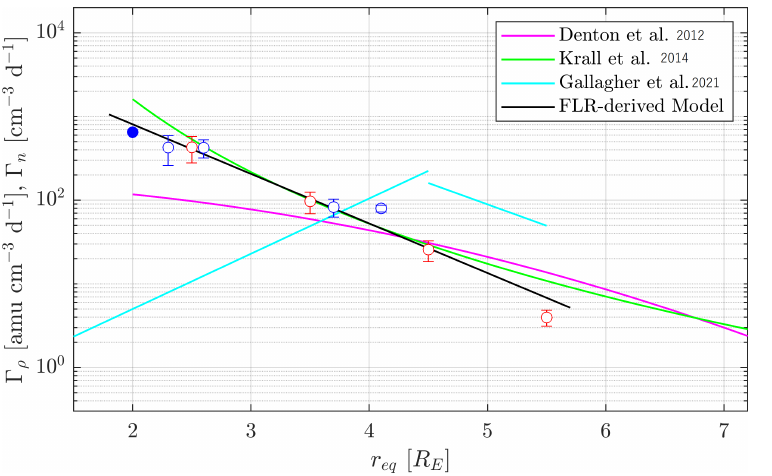
Figure 9. Geocentric distance dependence of the the day-to-day refilling rate estimated from FLRs observations in this (red circles) and in past works (blue circles) for the noon sector. The value indicated by the blue filled circle refers to 15:00 MLT. See Table 2 and text for details. The best fit found in Equation (9) is represented by the black line. Magenta, green and cyan curves are models derived by Denton et al. [41], Krall et al. [84] and Gallagher et al. [39], respectively, based on derived measuremetns of the electron number